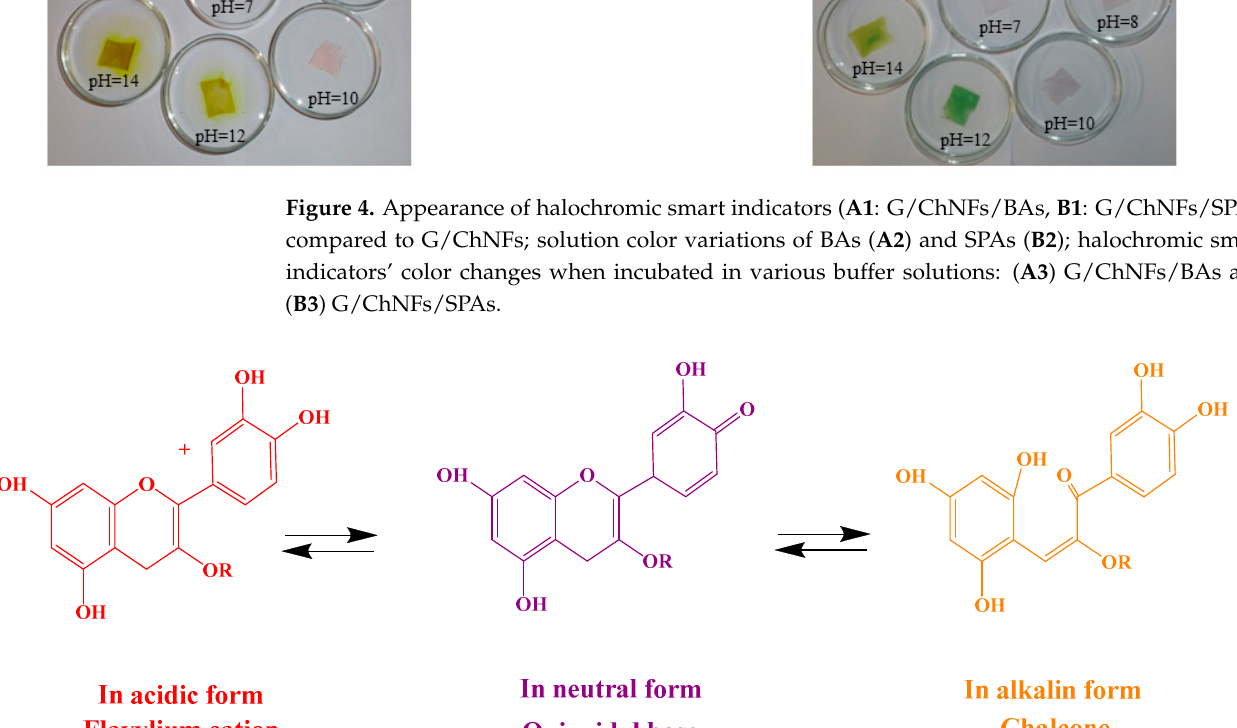
Figure 5. Chemical structures of anthocyanins at di ff erent pH values.